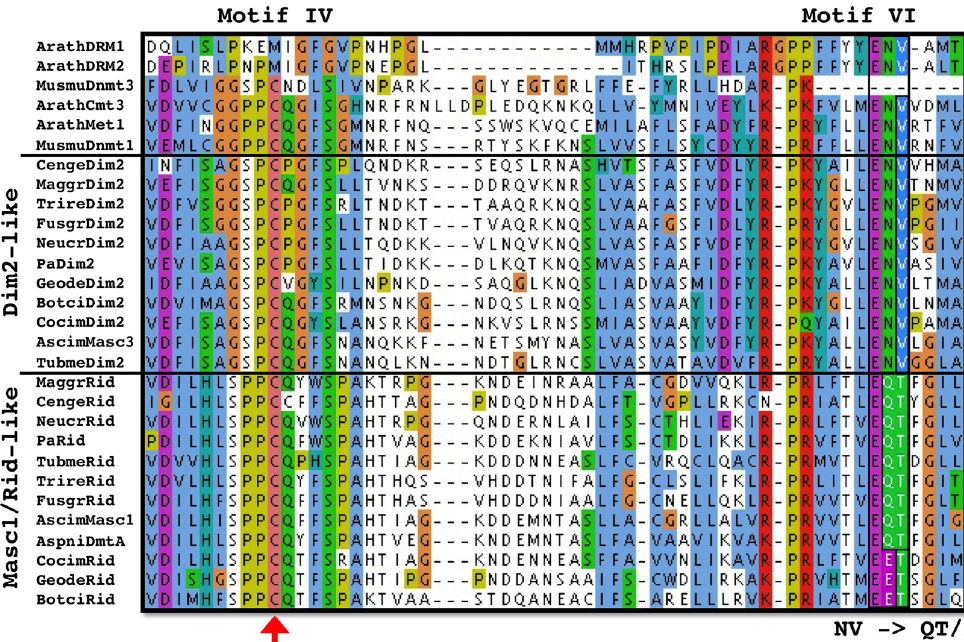
Fig 3. Evolution of the catalytic motifs IV and VI of the fungal Rid-like DNA methyltranferases. A key catalytic step is the nucleophilic attack of the DNA methyltransferases on the sixth carbon of the target cytosine. This attack is made by the cysteine residue (red arrow) of the conserved PCQ triad (motif IV). This reaction is catalyzed by protonation of the N3 position of the cytosine by the glutamate residue of the conserved ENV triad (motif VI). In the Masc1/Rid-like group of enzymes, the ENV triad is replaced by either the EQT triad (e.g. N . crassa Rid, A . immersus Masc1, P . anserina PaRid, etc.) or the EET triad (e.g. B . cinerea Rid, P . destructans Rid, etc.). Arath: Arabidopsis thaliana , Musmu: Mus musculus , Cenge: Cenococcum geophilum , Maggr: Magnaporthe grisea , Trire: Trichoderma reesei , Fusgr: Fusarium graminearum , Neucr: Neurospora crassa , Pa: Podospora anserina , Geode: Pseudogymnoascus destructans , Botci: Botrytis cinerea , Cocim: Coccidioides immitis . Ascim: Ascobolus immersus , Tubme: Tuber melanosporum , Aspni: Aspergillus nidulans . See above for accession numbers of the corresponding proteins.